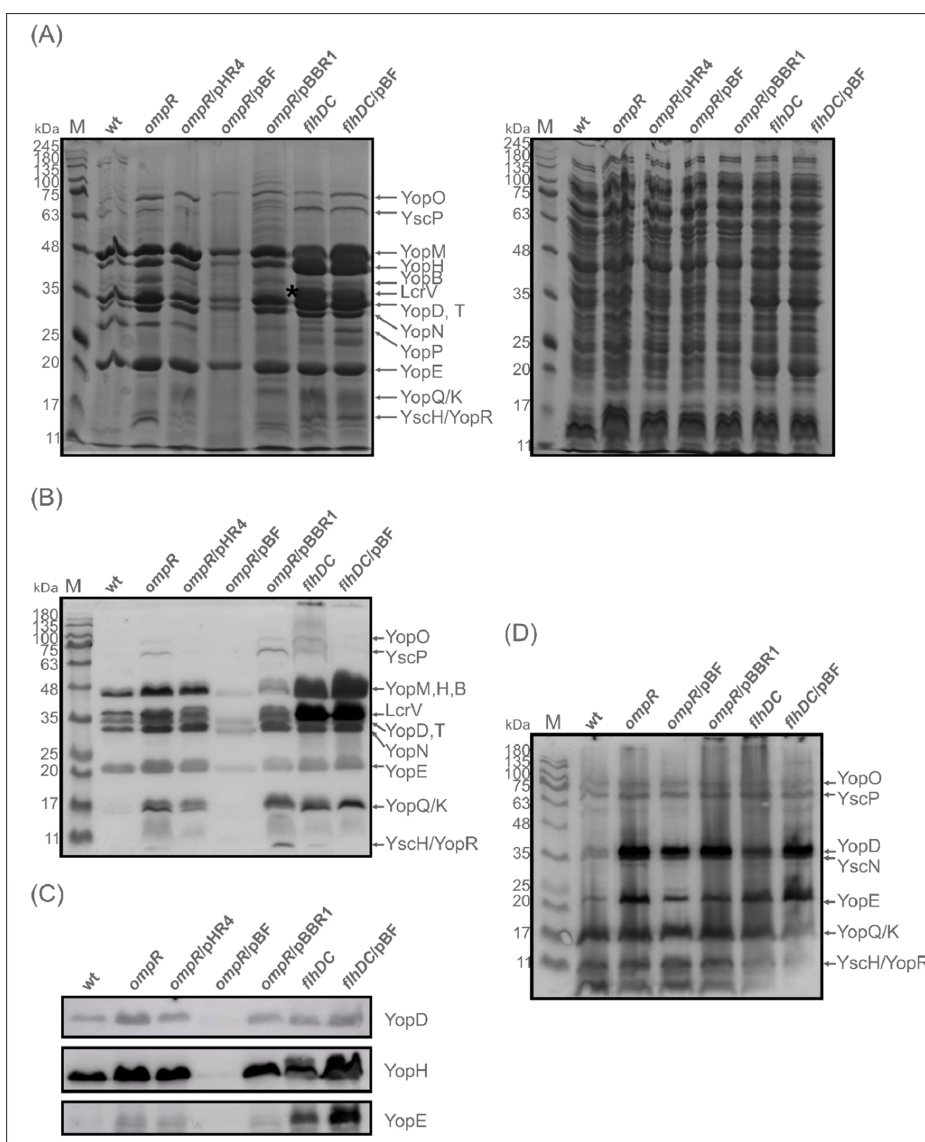
Figure 7. Expression and secretion of Yops by Y. enterocolitica ompR and flhDC mutants, and by these mutant strains overexpressing flhDC , were examined using 12% SDS-PAGE and Western blotting. ( A ) Coomassie blue-stained gel of secreted Yops (left panel) and cell extracts (right panel) of the following strains: wt (Ye9N), ompR (AR4), ompR /pHR4 (ARR12; mutant AR4 complemented with ompR ), ompR /pBF (AR4/pBBR1MCS-3 carrying flhDC ), ompR /pBBR1 (AR4 with empty vector pBBR1MCS-3), flhDC (DN1), flhDC /pBF (mutant DN1 complemented with flhDC ). Proteins from equal numbers of cells were examined. An asterisk indicates protein LcrV was identified in the flhDC mutant by LC-MS/MS. ( B ) Immunodetection of secreted Yops with an anti-Yops